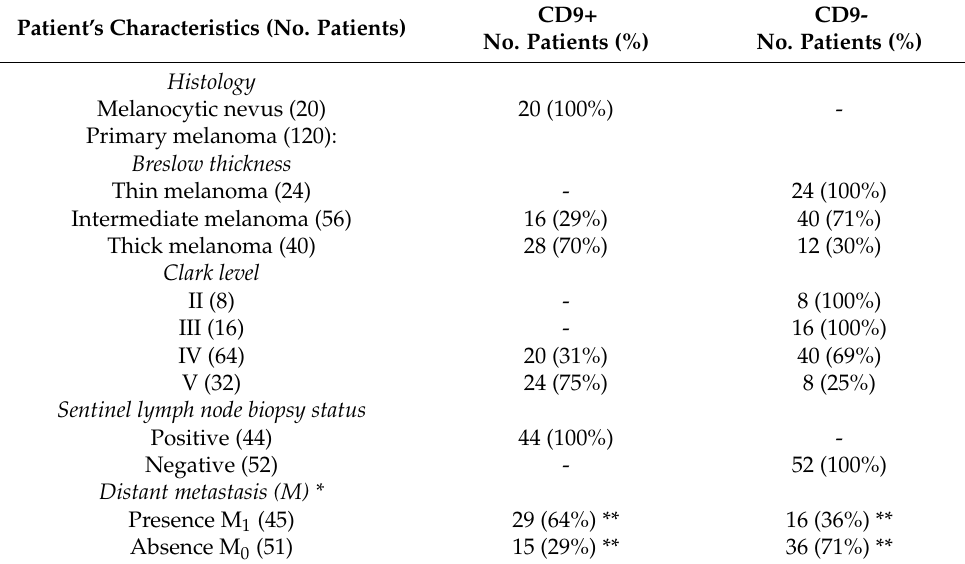
Table 4. Expression of CD9 in melanocytic nevi and primary melanomas. Patient’s Characteristics (No.